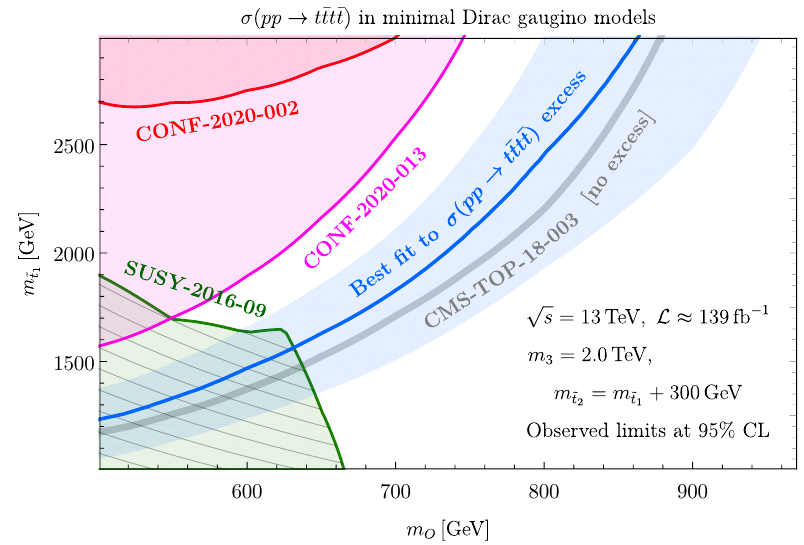
Figure 8 . Map of scalar sgluon parameter space, including regions excluded by relevant analyses and favored by the excess in σ ( pp → t ¯ tt ¯ t ) reported by ATLAS. Here the scalar sgluon and stop squark masses are varied while the Dirac gluino and stop mass splitting are fixed. The scalar branching fraction to top quarks BF ( O → t ¯ t ) increases with the ordinate. For context, also displayed are limits from the most recent CMS measurement, which sees no excess. See figure 9 and subsequent plots for expanded maps of color-octet scalar parameter space covering a wider range of